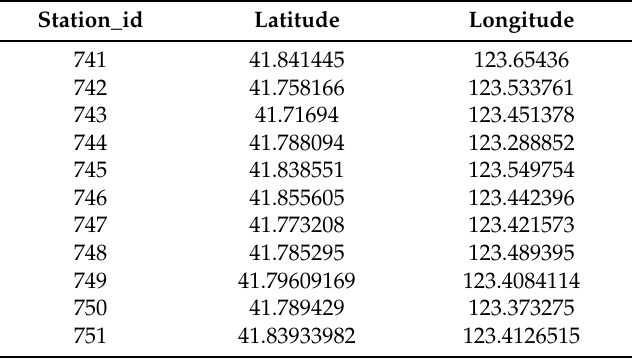
Table 4. Locations of monitoring stations.